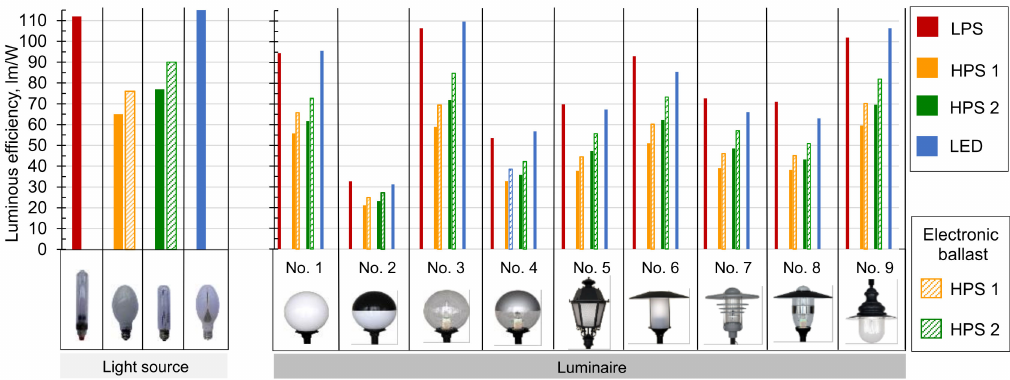
Figure 9. Calculated values of the luminous efficacy related to the light sources and